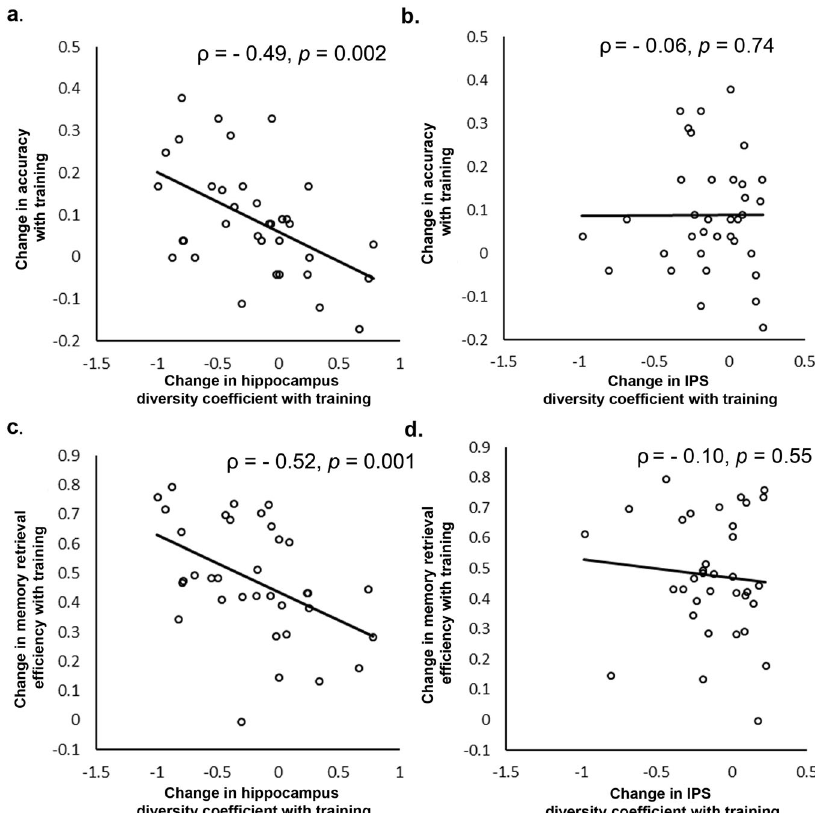
Fig. 6 Cognitive training-induced network reorganization of the hippocampus predicts learning and memory retrieval ef fi ciency gains. a Training- related change in diversity coef fi cient of the right rostral hippocampus was signi fi cantly negatively correlated with performance gains ( ρ = − 0.49, p = 0.002), such that children who showed greater decreases in diversity coef fi cient, exhibited larger gains in performance with training. b Changes in the intraparietal sulcus (IPS) diversity coef fi cient with training were not correlated with performance gains with training. c Training-related change in diversity coef fi cient of the right rostral hippocampus was signi fi cantly negatively correlated with gains in ef fi ciency of memory retrieval ( ρ = − 0.52, p = 0.001), such that children who showed greater decreases in diversity coef fi cient, exhibited larger gains in ef fi ciency of memory retrieval with training. d Changes in IPS diversity coef fi cient with training were not correlated with gains in memory retrieval ef fi ciency with training. N = 35